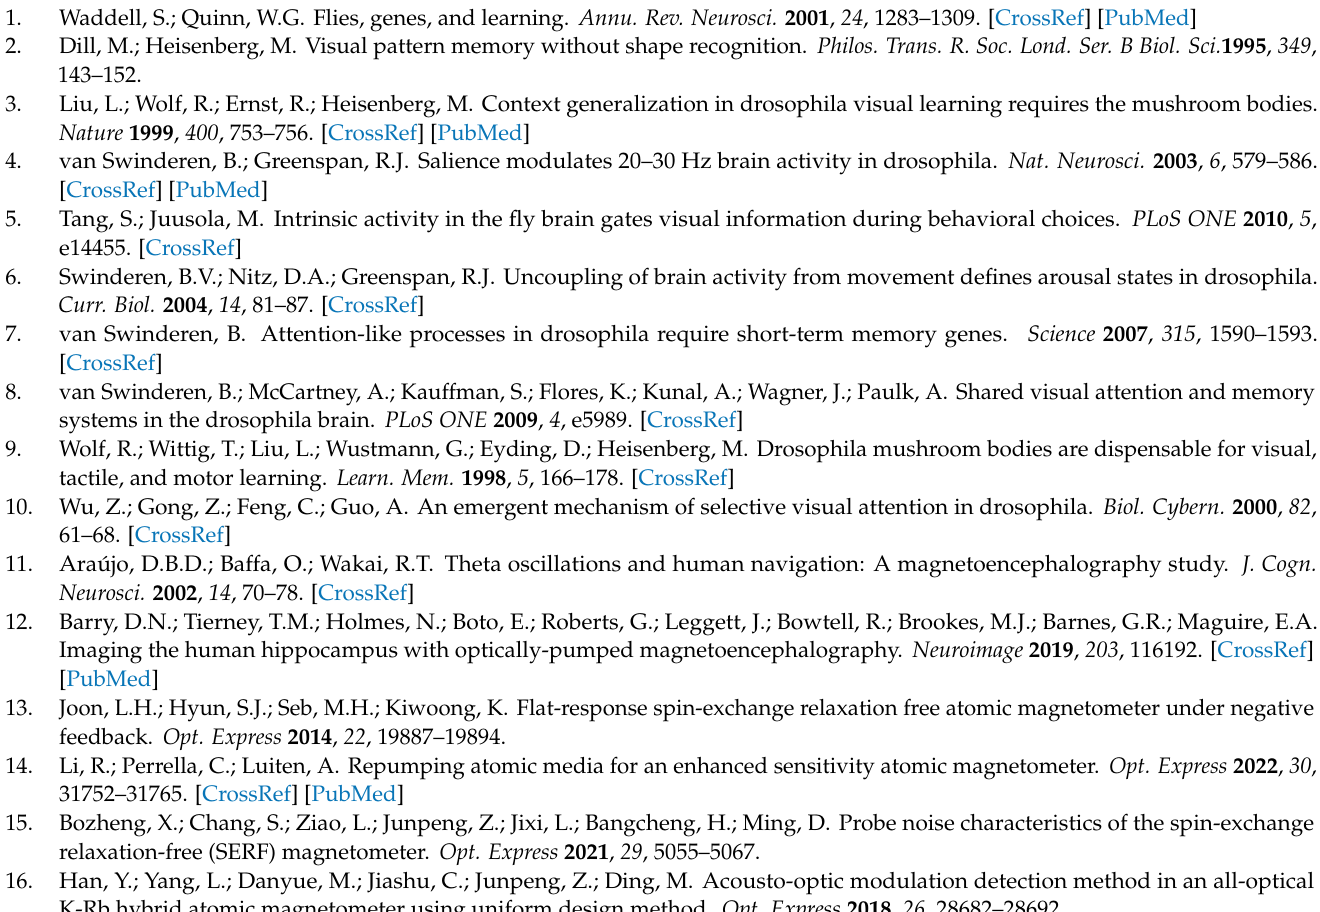
Figure S2: Power Spectral Density (PSD) between 1–30 Hz, dead flies (black line) and unloading (green line); Figure S3: Average 1–20 Hz NCM (±SEM): No Stimulation (yellow), Light Stimulation (red); Figure S4: Average 30–80 Hz NCM (±SEM): No Stimulation (yellow), Light Stimulation